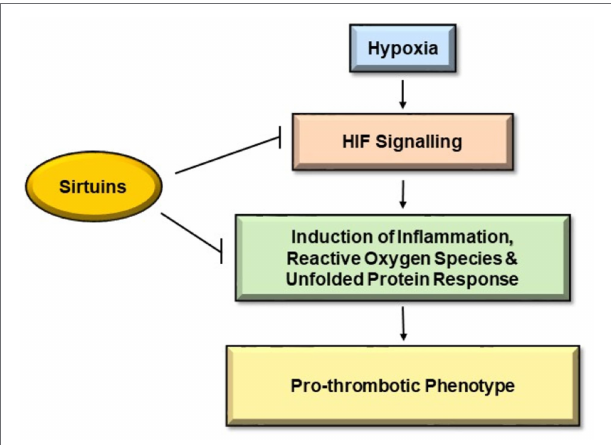
FIGURE 1 | Pathways inhibited by Sirtuins to mitigate hypoxia induced thrombosis. Hypoxia causes endothelial dysfunction leading to activation of hypoxia-inducible factor (HIF) signaling pathways, which further leads to induction of inflammation, reactive oxygen species (ROS), and unfolded protein pathway (UPR). These pathways initiate coagulation cascade giving rise to pro-thrombotic phenotype. Sirtuins hamper HIF signaling pathways and hinder the induction of inflammation, ROS, and UPR, thereby indicating a protective role against hypoxia-induced